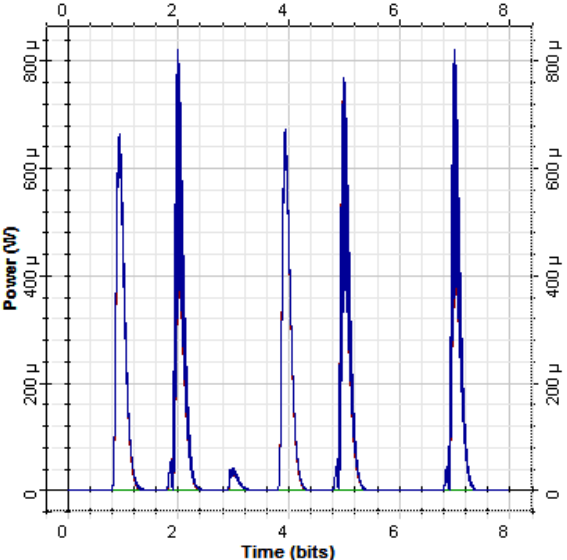
Figure 7. XOR gate output in the time domain.